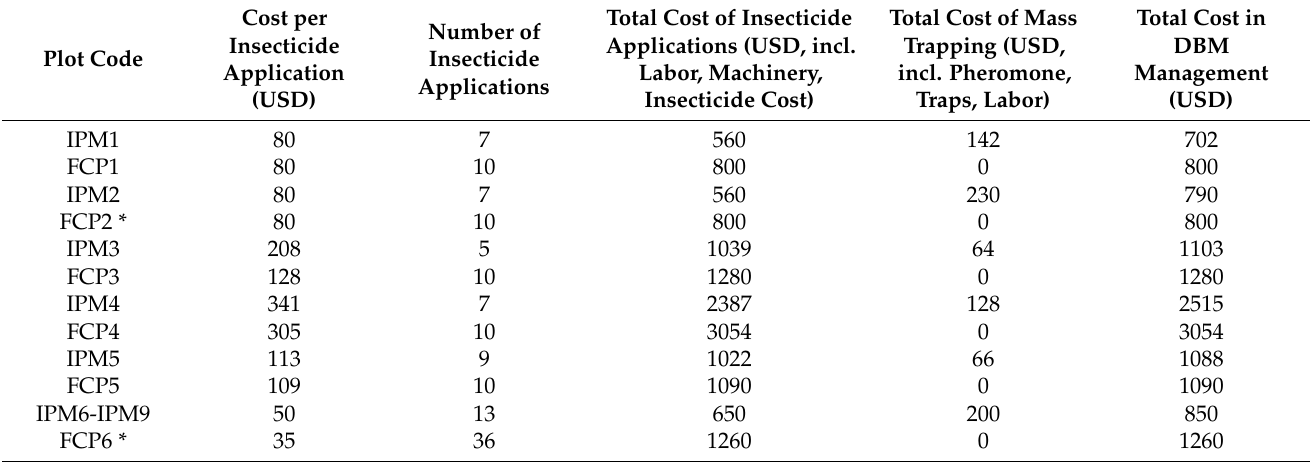
Table 3. Cost of DBM management per plot.